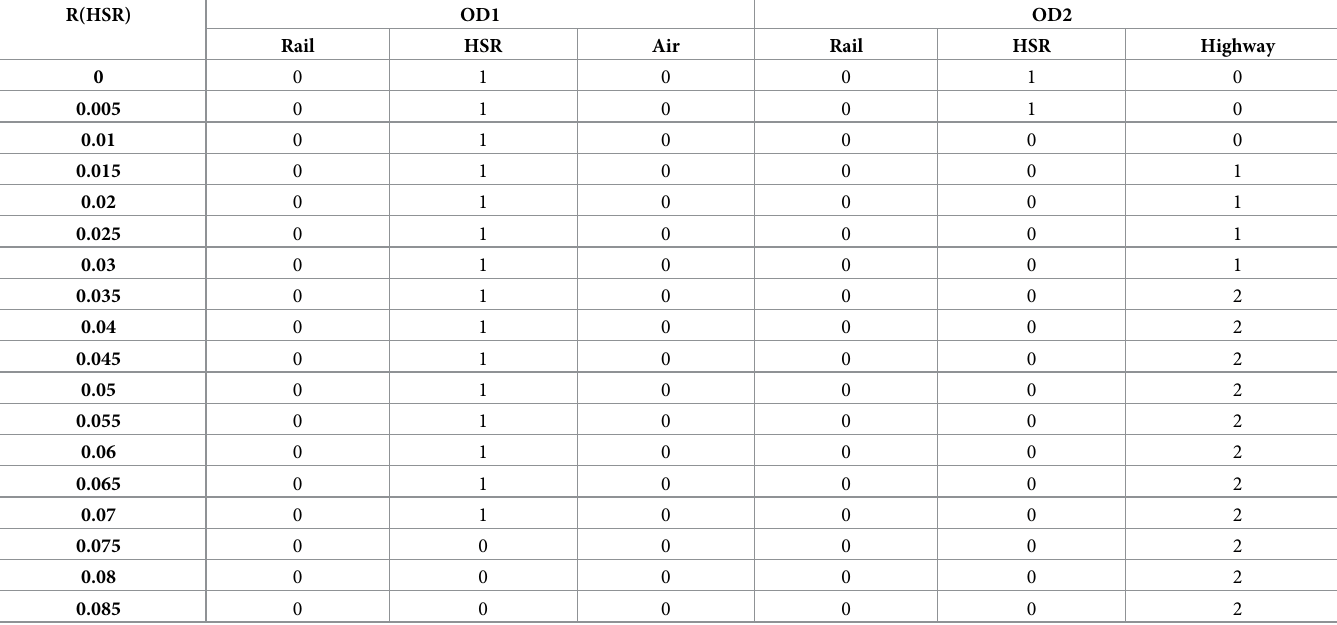
Table 5. New construction of various transportation modes in the